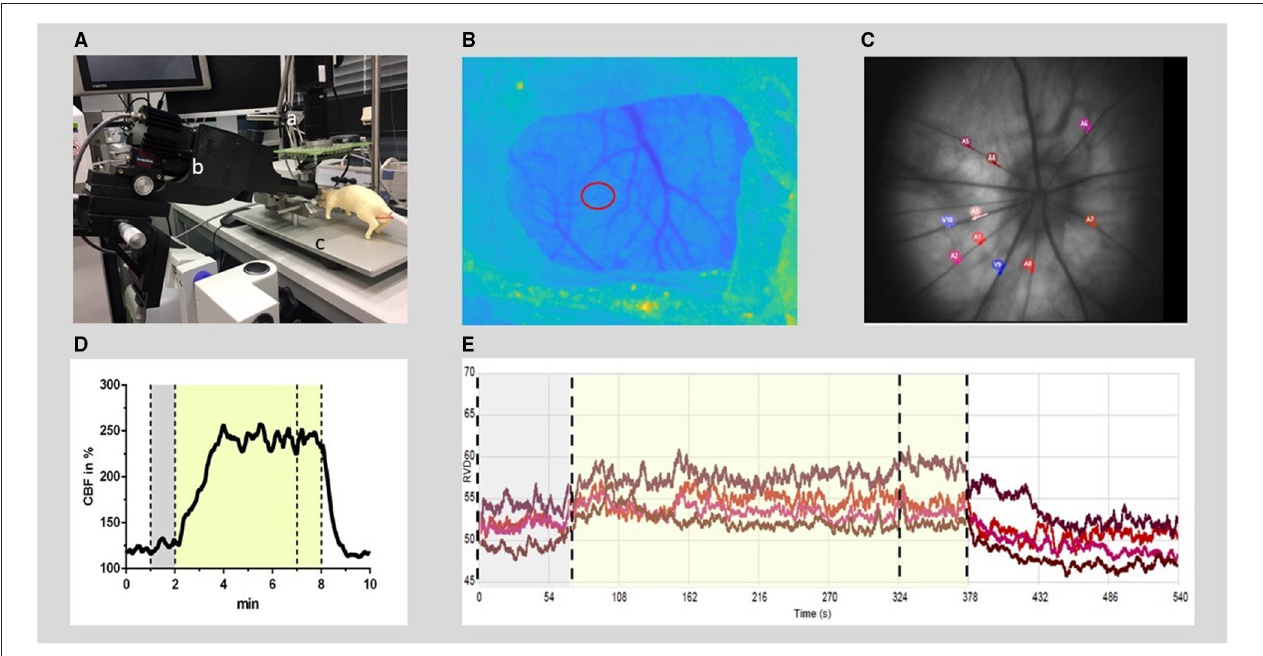
FIGURE 1 | Experimental setup for RVD and CBF recording and offline analysis. (A) Experimental setup: the rat (dummy rat used for illustration) was positioned in a stereotactic frame (c) under a superficial tissue imaging system (a) and CBF was calculated from continuously recorded raw images of laser speckle contrast. A retinal vessel analyzer (b) was positioned in front of the left eye. RVDs were recorded intermittently during hypercapnia challenges induced by hypoventilation. (B) Anatomical image at the cranial window (thinned bone) with the region of interest for CBF time course calculation (red circle). (C) Example of a fundus image: 4–8 arteries were selected (red and purple circles) for offline analysis of RVD from each video sequence. (D) Typical time course of CBF during the hypercapnic period at baseline. (E) Example of diameter analysis of retinal vessels at baseline, performed by the commercial RCrodent Imedos- software. (D,E) The time period of hypercapnia is marked by the transparent yellow area, dotted lines indicate the recording period used for baseline (gray) and hypercapnic response calculation, respectively. RVD, retinal vessel diameter; CBF, cerebral blood